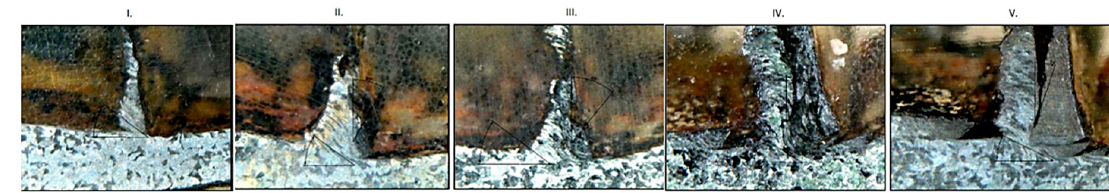
Figure 19. Successive chip roots (magnified 200×) of carbon steel EN 16MnCr5 steel for orthogonal cutting, with the parameters v c = 15 m·min − 1 , a p = 0.4 mm, γ = 3°, λ s = 0°.